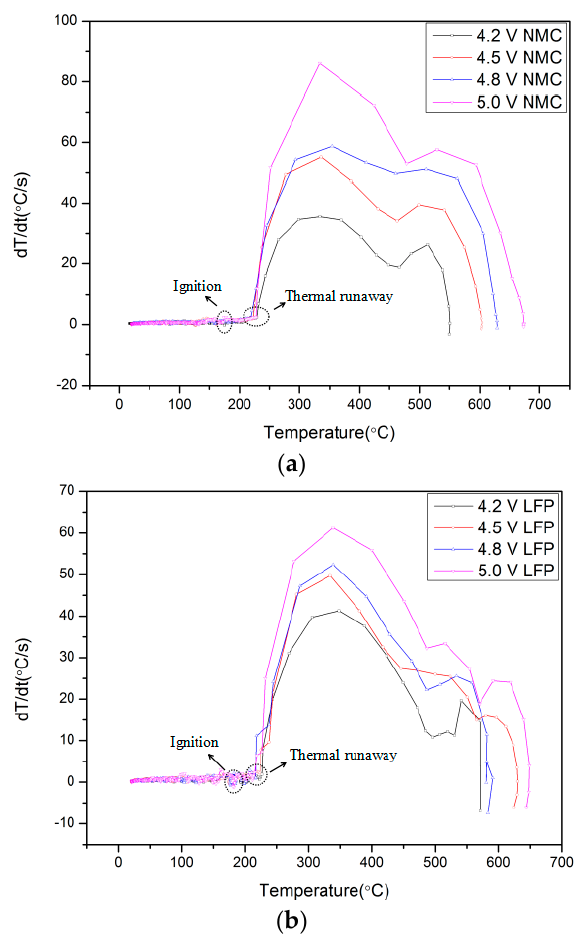
Figure 8. The typical curves of LIB temperature rise rate vs. surface temperature during tests: ( a ) NMC; ( b ) LFP.